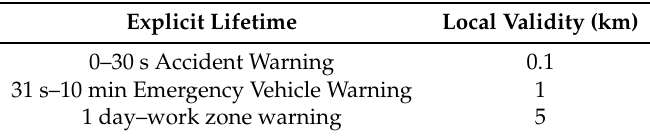
Table 1. Cooperative Intelligent Transport Systems (C-ITS) information lifetime and local validity in Reference